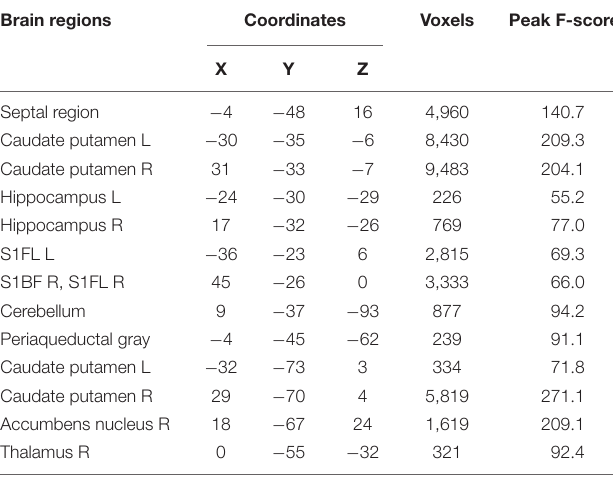
TABLE 2 | Voxel-based morphometry analysis revealed some GM regions with interactions of group and age in SHRs and WKY rats. Brain regions Coordinates Voxels Peak